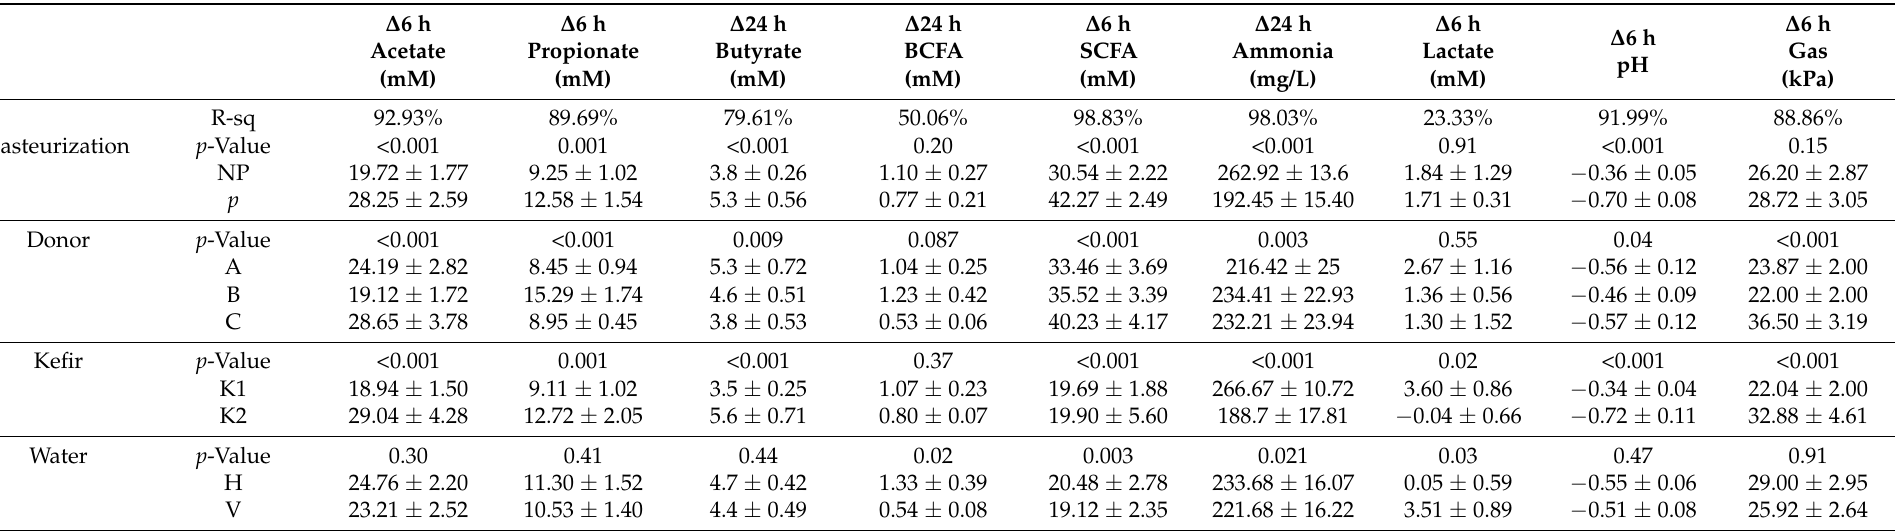
Table 1. Summary results of a General Linear Model of different metabolites and variables of the study, including donor, product pasteurization, kefir inoculum and type of water used for kefir